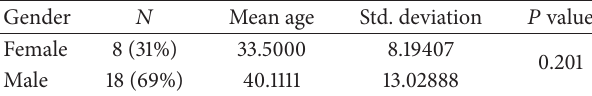
Table 6: Patients with dual infection (age and gender).